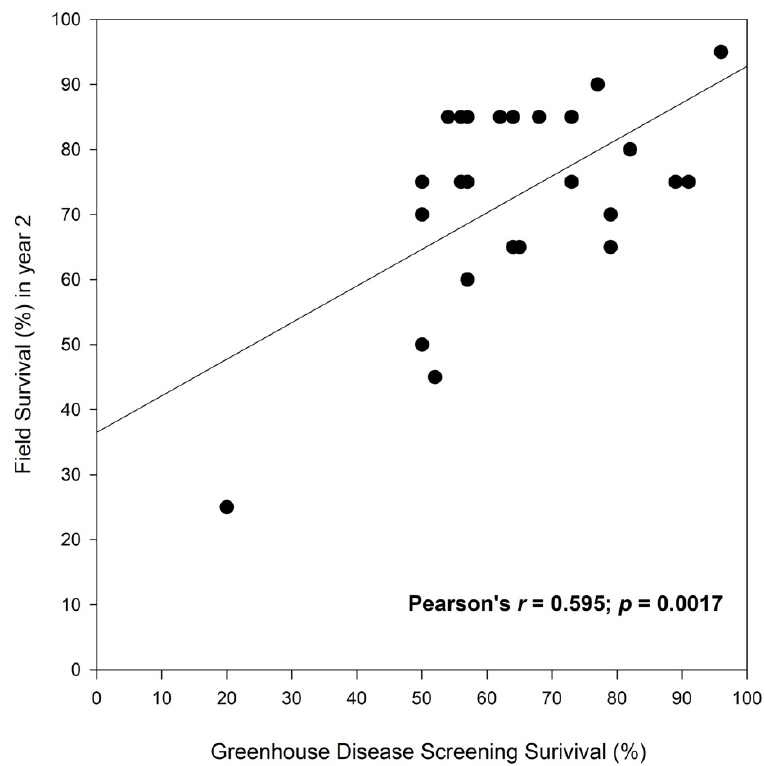
Figure 2. Correlation analysis used to illustrate the relationship between seedling survival during the greenhouse disease screening trial ( n = 25) versus field survival in year 2 ( n = 20) for 25 koa families. Each dot represents the overall survival of the particular family.